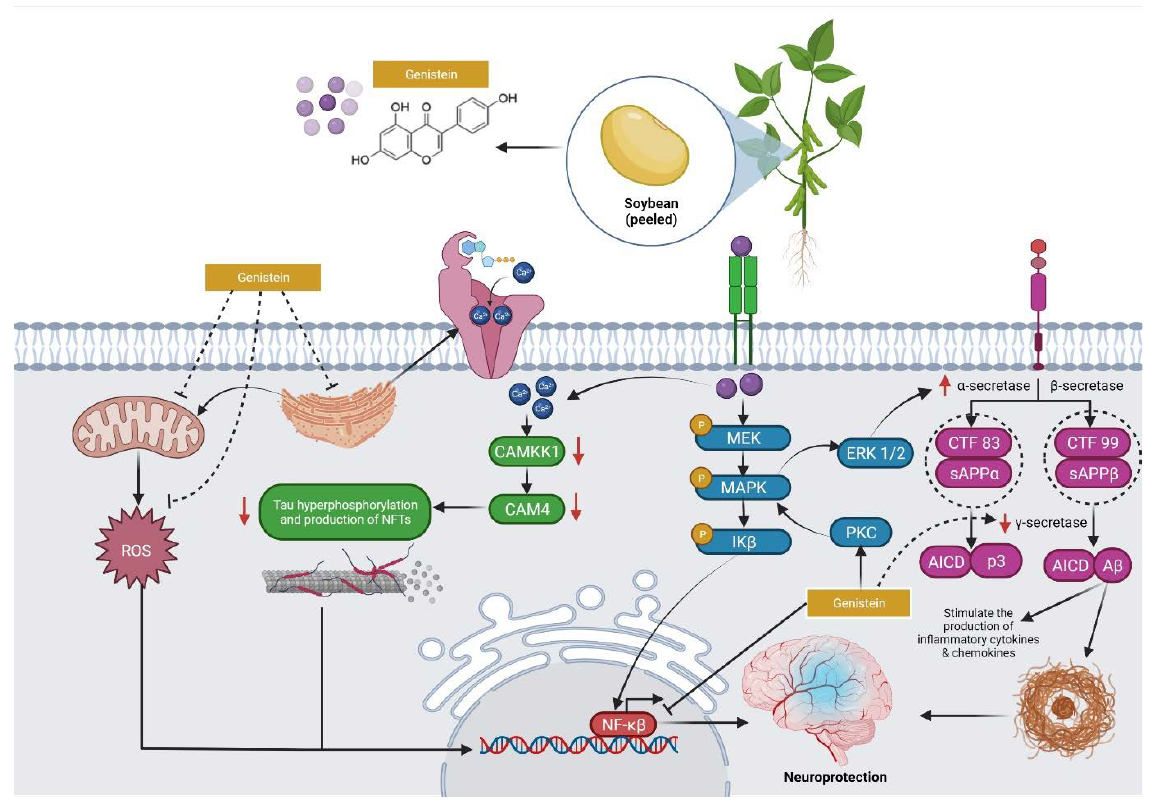
Figure 3. Neuroprotective effects of genistein. The soy isoflavone genistein, which can interact directly with the targeted signalling proteins and maintain their activity to counteract the progression of Alzheimer’s disease, may also help to ameliorate brain deficits caused by A β . Abbreviations: CAMKK1, Calcium/calmodulin-dependent protein kinase kinase 1; CAM4, Calmodulin-4; MAPK, Mitogen-activated protein kinase; Ik β , ERK 1/2, Extracellular signal-regulated kinase 1/2; PKC, Protein kinase C; CTF 83 & 99, CCAAT box-binding transcription factor 83 & 99; sAPP α , Soluble amyloid protein procurer alpha; sAPP β , Soluble amyloid protein procurer beta; AICD, Amyloid precursor protein Intracellular cytoplasmic/C-terminal domain; A β , Amyloid beta; ROS, Reactive oxygen species; NFTs, Neurofibrillary tangles; NF- κβ , Nuclear factor kappa light chain enhancer of activated B